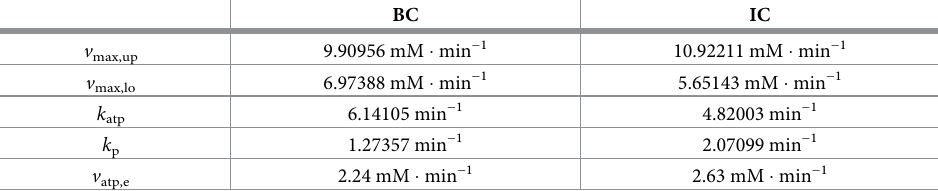
Table 2. Genotypes used in no-mutation coexistence simulations. Also indicated are the expression costs of the